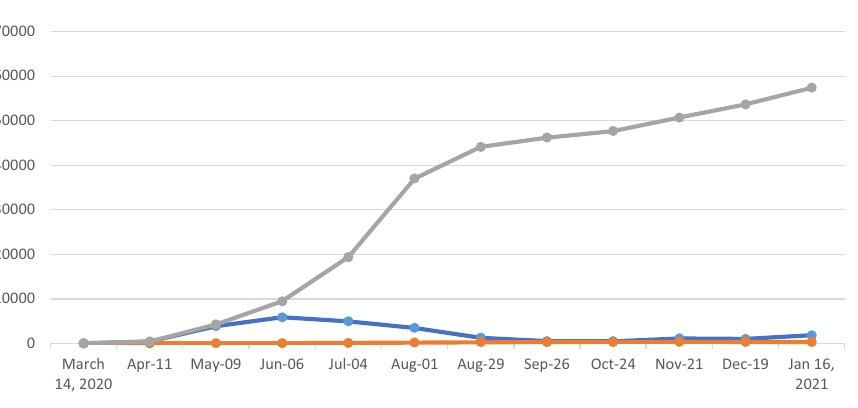
Figure 2. COVID-19